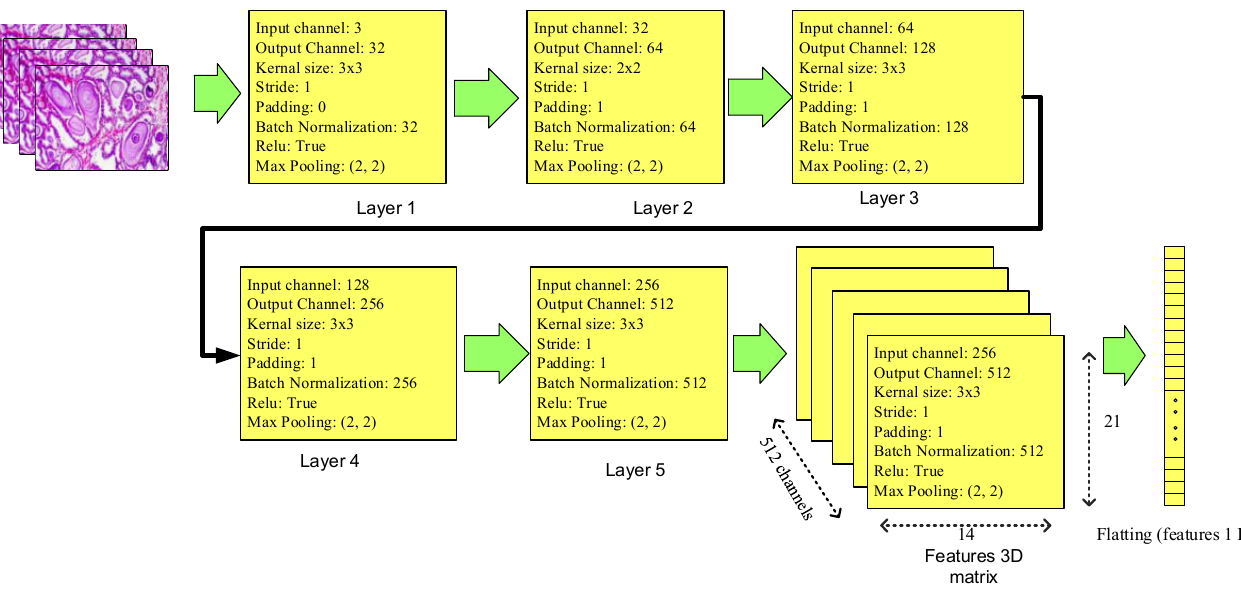
Figure 4. Configurations of the feature extraction phase of